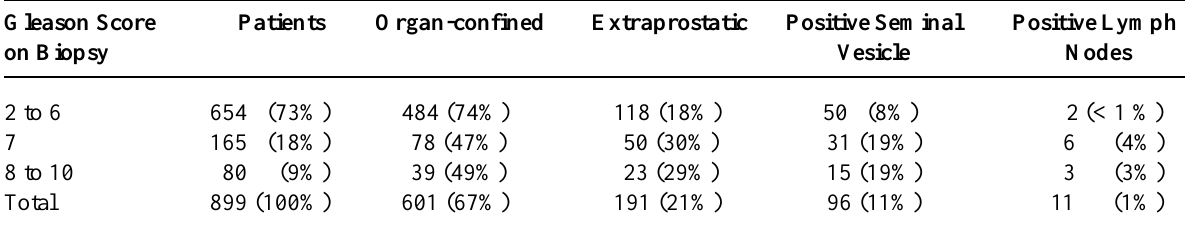
Table 1 – Gleason score on biopsy and location of prostate cancer in the surgical